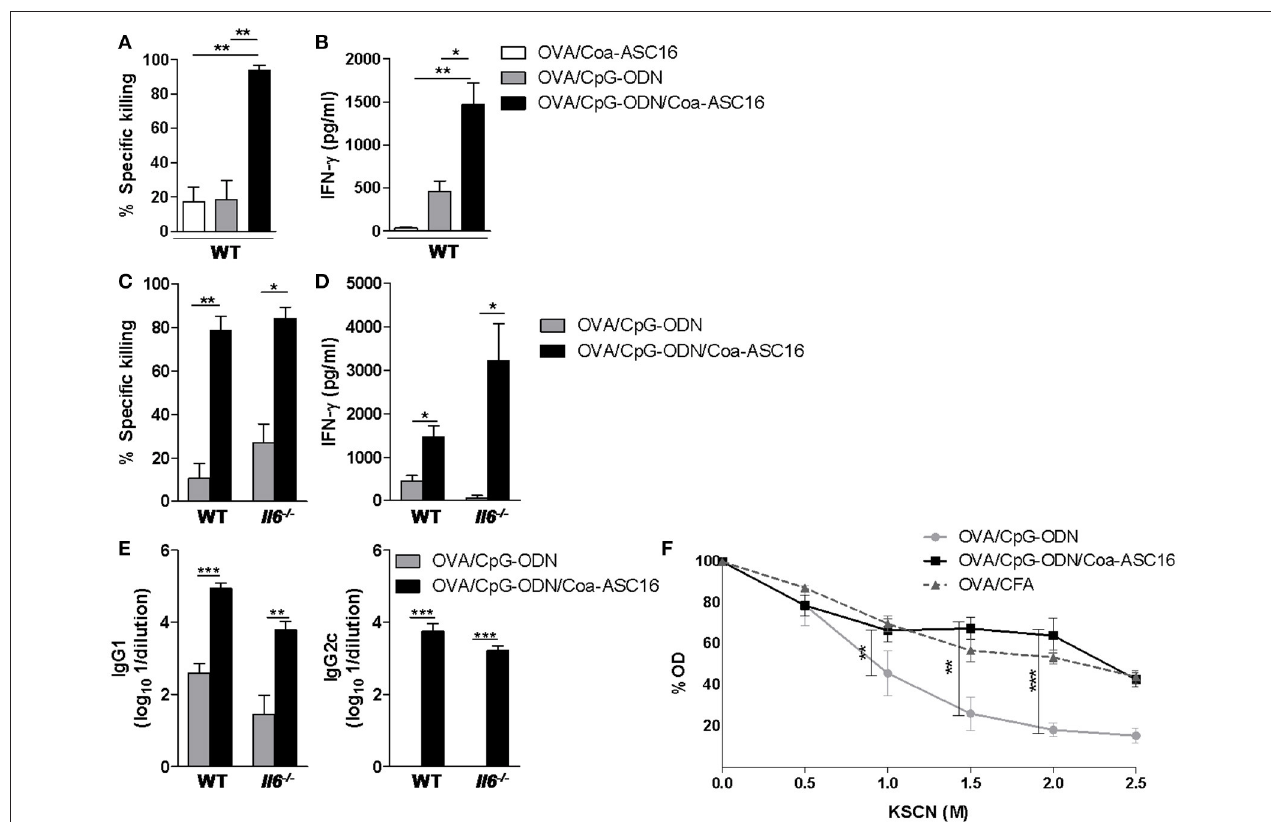
FIGURE 2 | Formulation of OVA/CpG-ODN with Coa-ASC16 optimizes humoral and CD8 + T-cell responses independently of IL-6. WT or Il6 − / − mice were immunized with OVA/Coa-ASC16, OVA/CpG-ODN, OVA/CpG-ODN/Coa-ASC16 (on days 0, 7, and 14) or OVA/CFA (days 0, 15, and 30). (A,C) In vivo killing assay and (B,D) ex vivo IFN- γ secretion by splenocytes after stimulation with SIINFEKL peptide determined by ELISA on day 21. (E) Titers of OVA-specific IgG1 and IgG2c in plasma determined by ELISA on day 21. (F) WT mice. Avidity OVA-specific IgG in plasma determined by ELISA using KSCN elution seven days after the last immunization. The data show the mean ± SEM of individual values (3-4 mice/treatment group in each experiment) and are representative of two independent experiments performed. * p < 0.05, ** p < 0.01, *** p < 0.001.